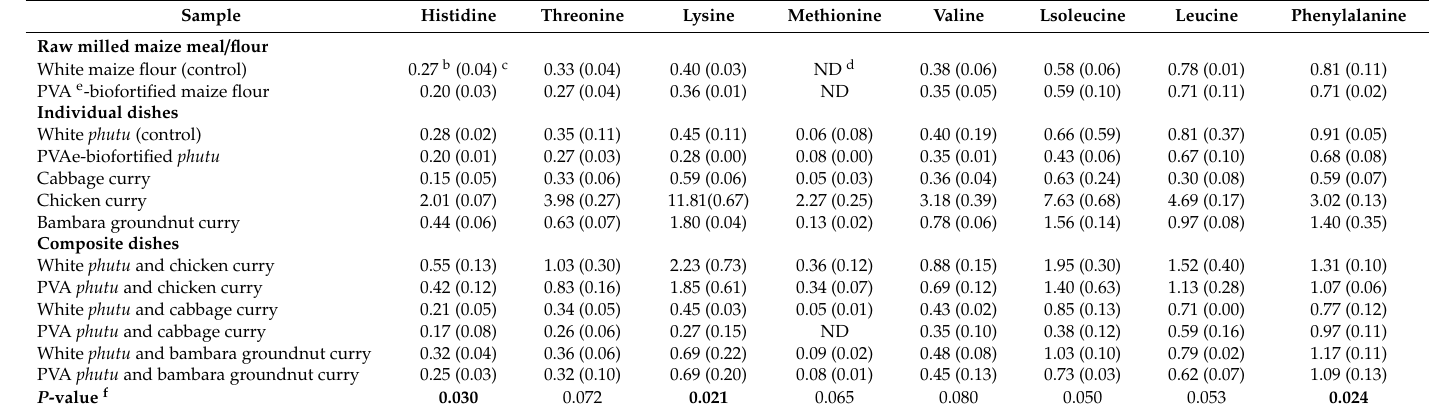
Table 3. Essential amino acid composition of uncooked and cooked samples except sweet potato (g / 100 g, DW a ). Sample